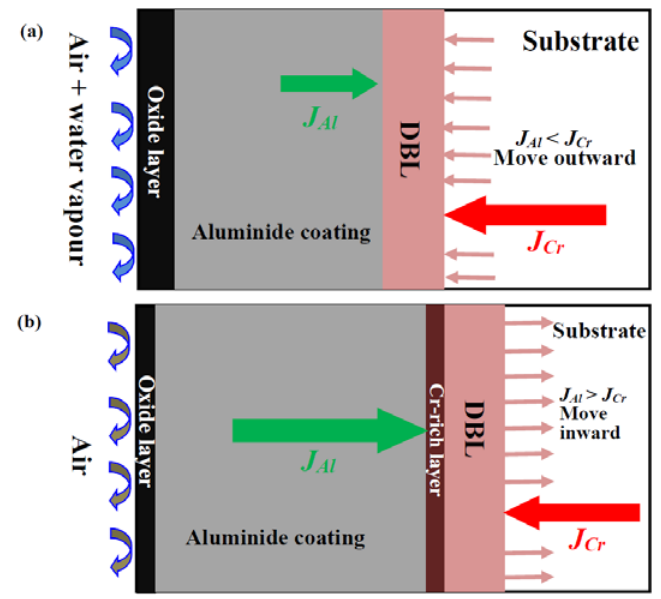
Figure 9. Schematic of the movement of the interdiffusion zone on an IN738 superalloy after being oxidized for 150 h: ( a ) in air plus water vapour and ( b ) in air at 1050 °C.